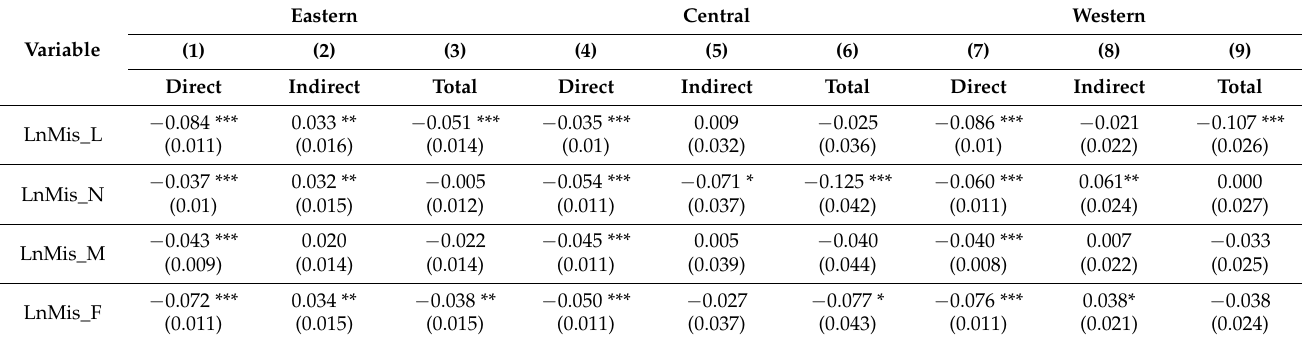
Table 12. Heterogeneity tests: Effect